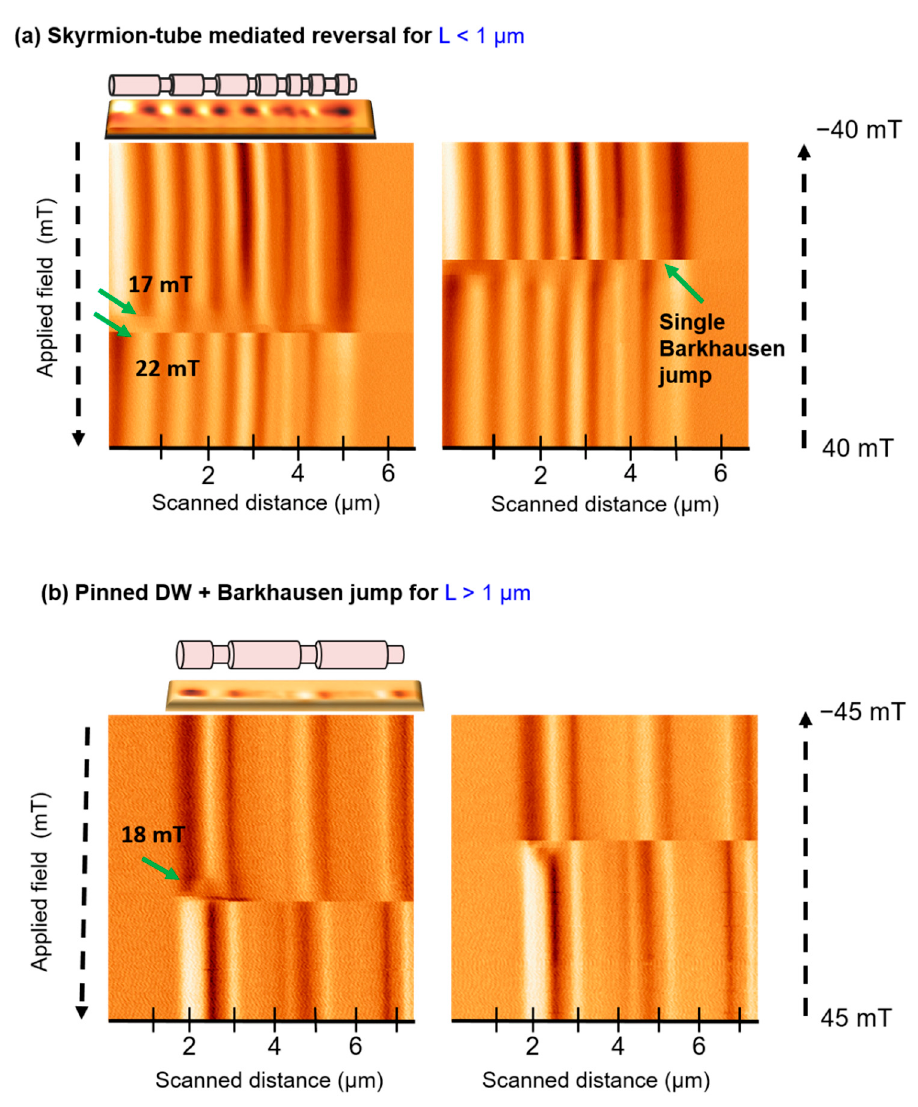
Figure 4. Advanced (3D-mode) MFM image of different magnetization reversal processes. Figure 4 . Advanced (3D-mode) MFM image of different magnetization reversal processes. ( a ) Skyr- mion-tube mediated reversal. ( b ) Domain wall pinning followed by a Barkhausen jump. ( a ) Skyrmion-tube mediated reversal. ( b ) Domain wall pinning followed by a Barkhausen